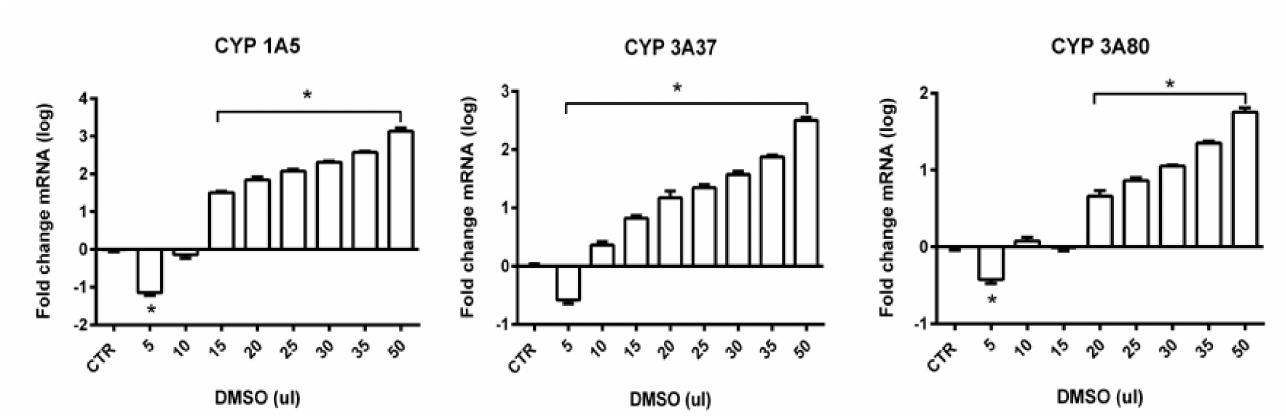
Figure 9. Relative gene expression from RT-qPCR analysis for genes CYP1A5 , CYP3A37 and CYP3A80 (* statistically significant difference, p < 0.01; log-log